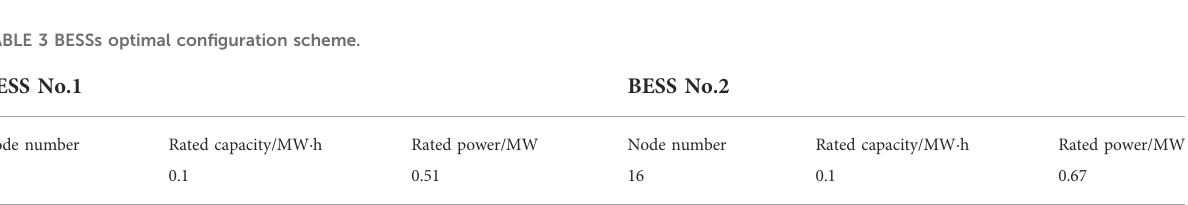
FIGURE 3 Topology of the extended IEEE-33 node test system.